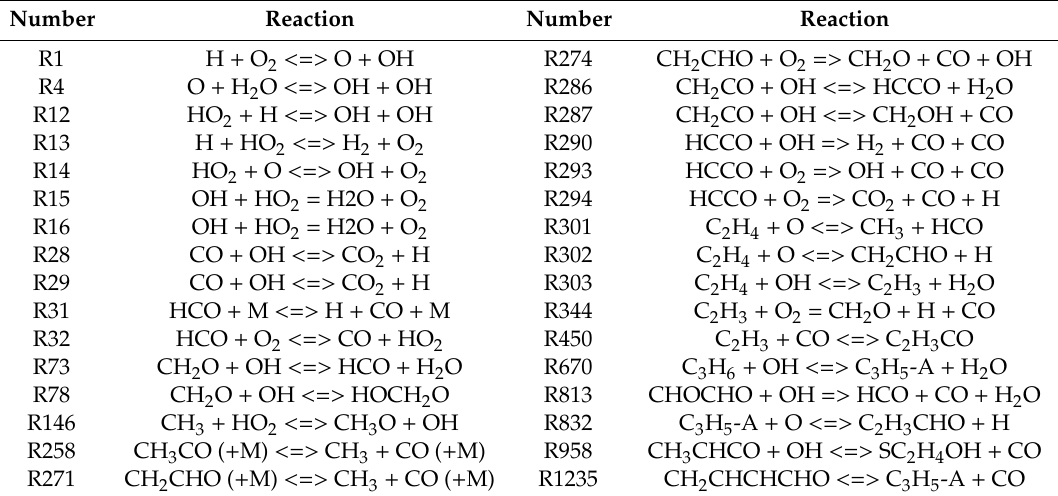
Table 2. The key reactions for the production and annihilation of